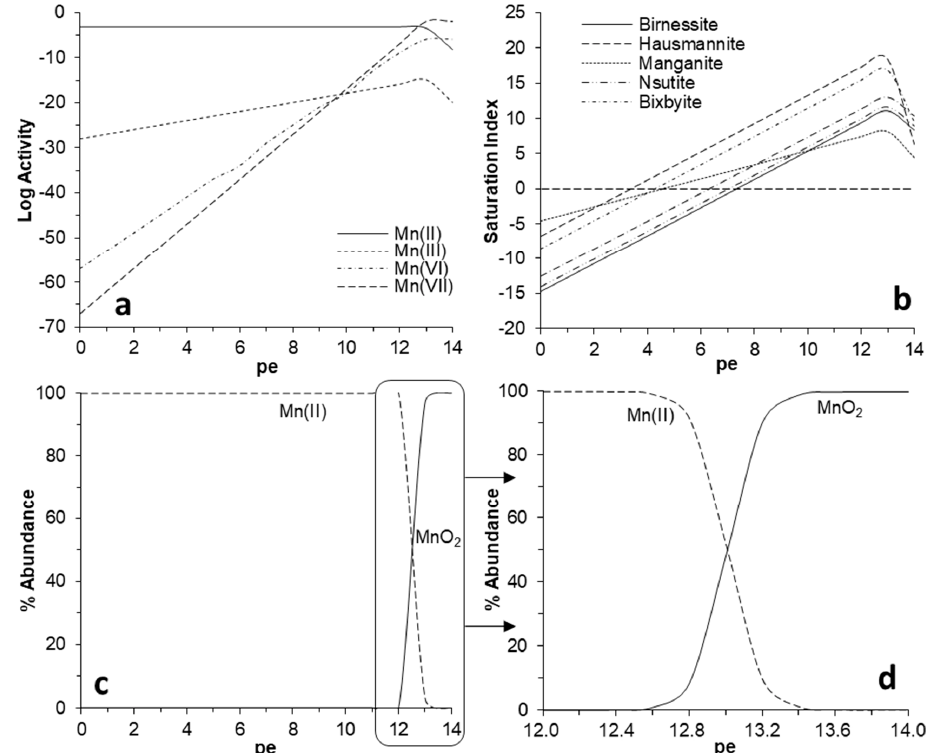
Figure 10. ( a ) Variation of ionic activities for different Mn species (Mn(II), Mn(III), Mn(VI), Mn(VII)) in the pe range 0–14. ( b ) Solubility of different manganese oxi-hydroxides (as defined by their corresponding saturation index) in the pe range of 0–14. ( c ) Relative distribution (in % molar abundance) of Mn(II) vs. MnO 2 . ( d ) Enlargement of ( c ) showing the evolution of Mn species in the critical pe range of 12–14. Calculations conducted with PHREEQCI using the minteqa2.v4 database. For all plots, the conditions were chosen to roughly resemble typical water composition of Guadiana and La Zarza mine pit lakes ( T = 25 ᵒ C, pH = 8.5, [Mn] = [Na] = 10 − 3 M, [Ca] = 10 − 2 M, [K] = 10 − 4 M).